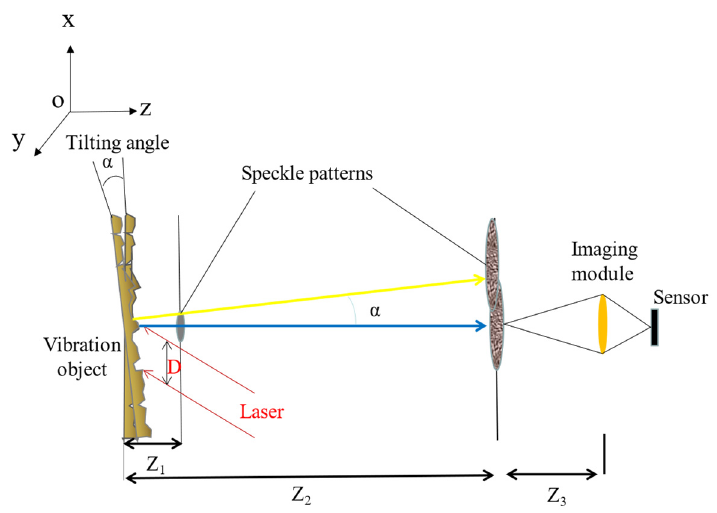
Figure 1. Theoretical description of the system. The conversion between object vibration and speckle pattern displacement.